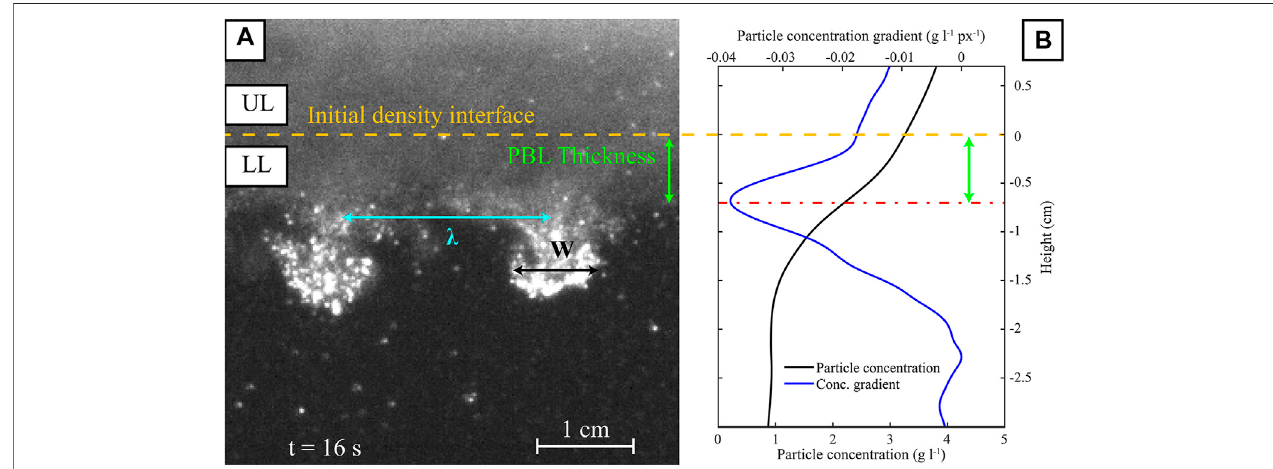
FIGURE 5 | (A) Visualization of fi ngers ’ geometrical properties for experiment A5 (5 g l − 1 ) 16 s after removing the barrier. The yellow dashed line is located at the position of the initial density interface and separates the Upper Layer (UL) and the Lower Layer (LL). Green, black and blue arrows indicate the PBL thickness and fi nger width ( W ) and spacing ( λ ), respectively. (B) Variation in the particle concentration (black line) and its gradient (blue line) with height, in the region across the density interface 16 s after barrier removal. The lower boundary of the PBL is identi fi ed at the level where the particle concentration gradient reaches its minimum value (represented by the dotted red